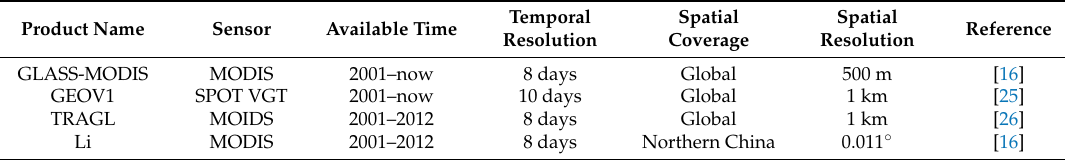
Table 1. The summary of fractional vegetation cover (FVC) data sets used in the